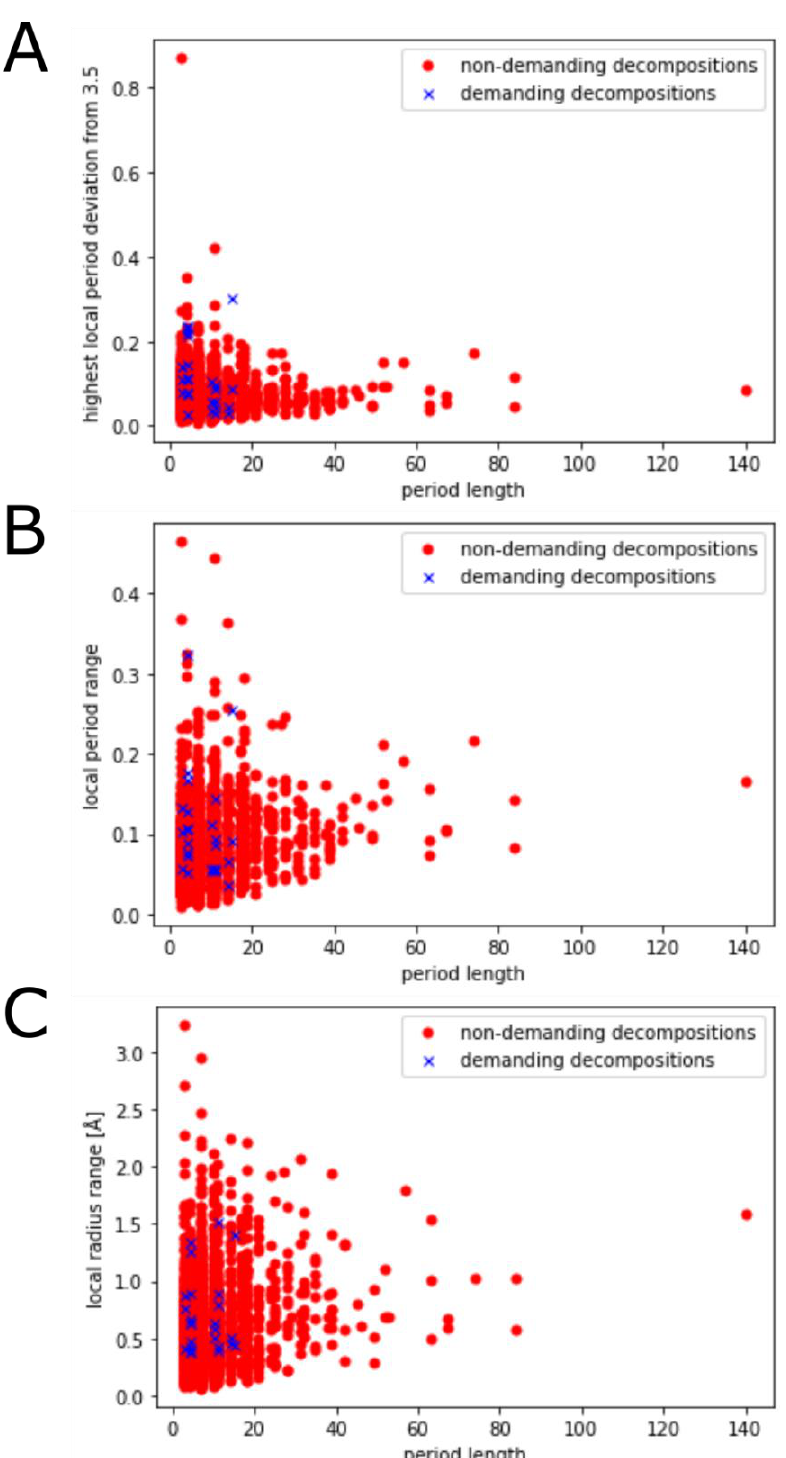
Figure 3. Comparison of structural properties between coiled coils with demanding (at least one repeat of interhelical contact distance 3 or 4) and non-demanding decompositions. ( A ): Comparing the highest local period deviation, i.e., the highest deviation along the coiled coil from the base periodicity of 3.5 Å. ( B ): Comparing the difference between the maximum local periodicity and the minimum periodicity along the coiled-coil structure. ( C ): Comparing the difference between the maximum local radius and the minimum local radius along the coiled-coil structure.